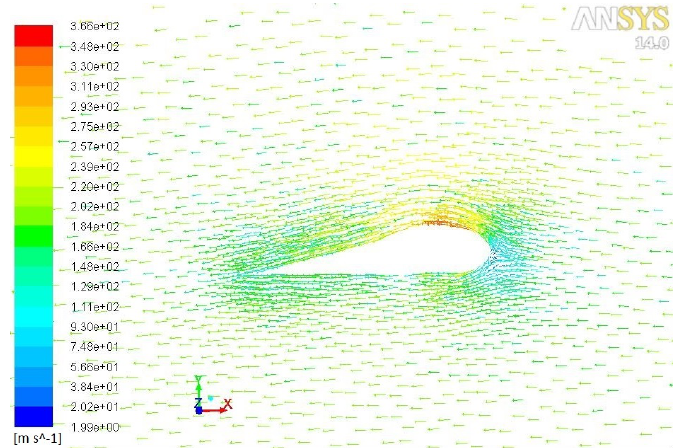
Figure 7. Variation of fluid